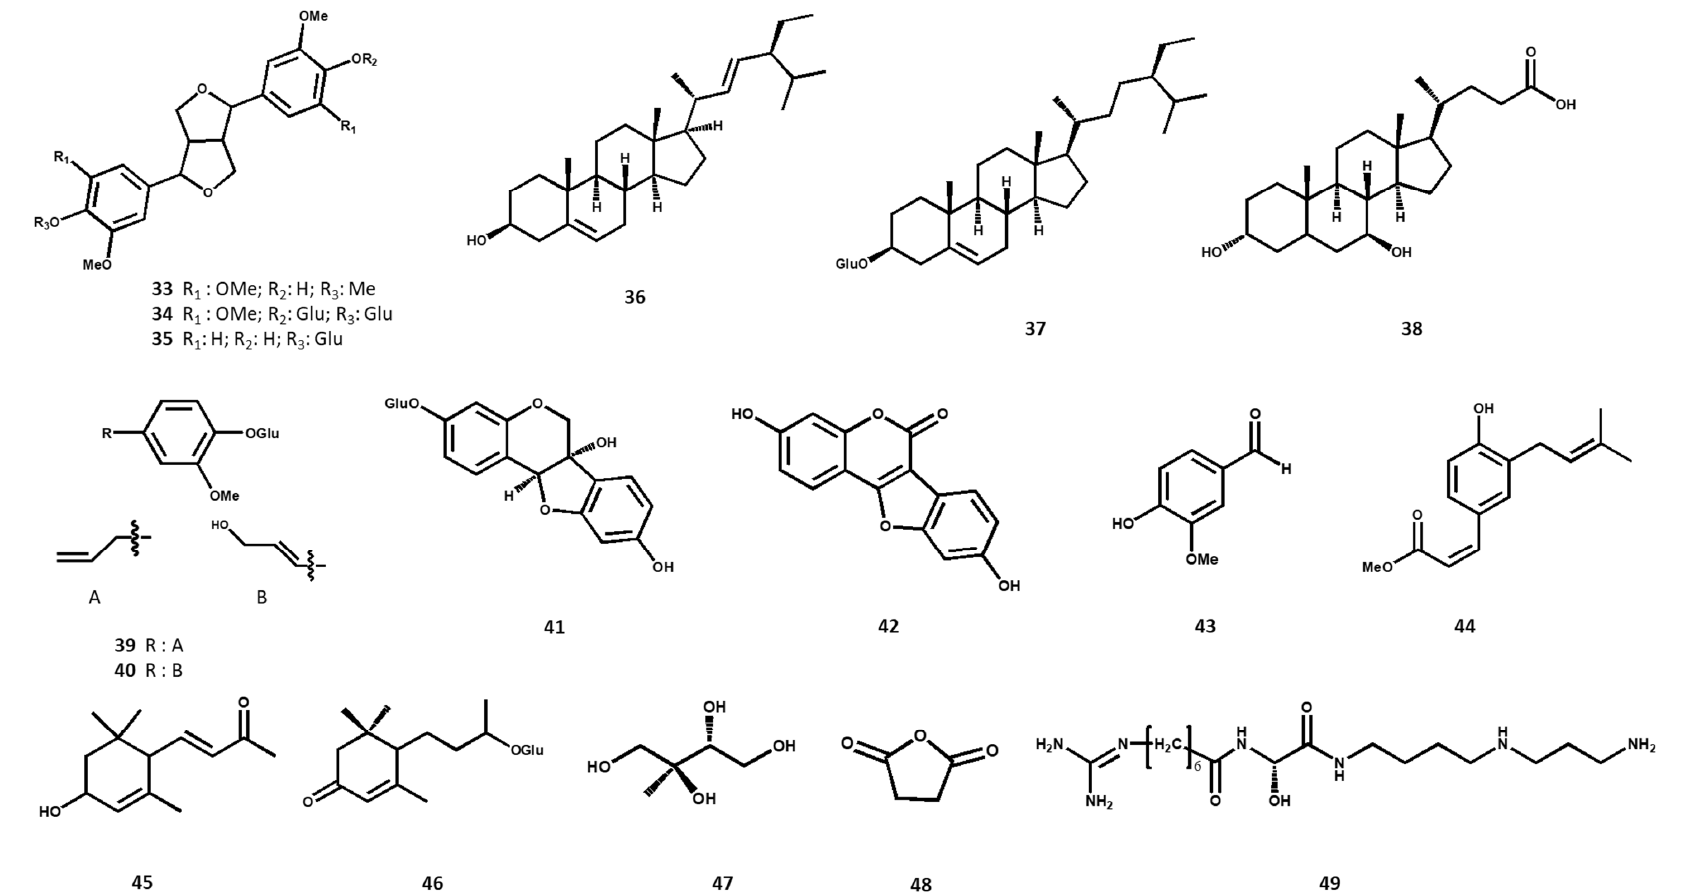
Figure 1. Chemical structures of the non-volatile phytochemicals identified from Ducrosia species.